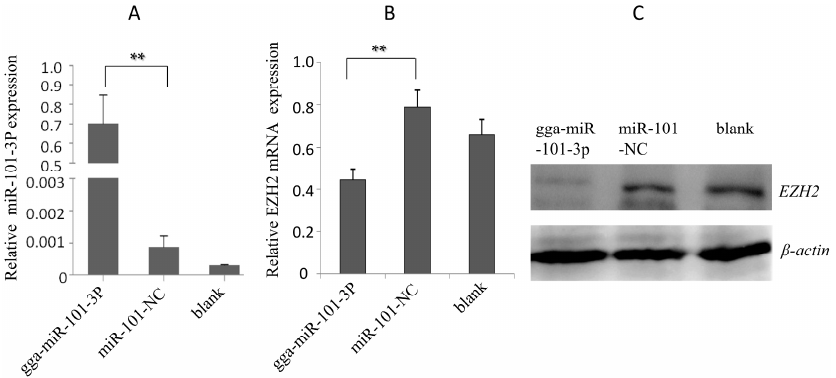
Figure 3. Over-expression of gga-miR-101-3p repressed EZH2 expression. ( A ) Over-expression of gga-miR-101-3p in DF-1 cells; ( B ) The mRNA level of EZH2 in DF-1 cells overexpressing gga-miR-101-3p was reduced. Error bars represent the mean ± SD of triplicate experiments; ( C ) Western blot analysis of EZH2 protein expression in DF-1 cells transfected with gga-miR-101-3p. A mock transfection was set as a blank; the expression of β -actin was used as a loading control. Each experiment was repeated three times, and each sample was assayed in triplicate. The asterisks represented statistically significant differences (** p < 0.01).